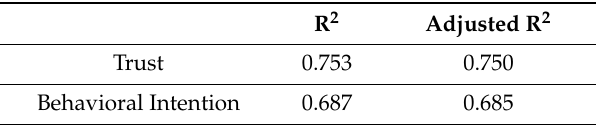
Table 5. R-squared of the model.